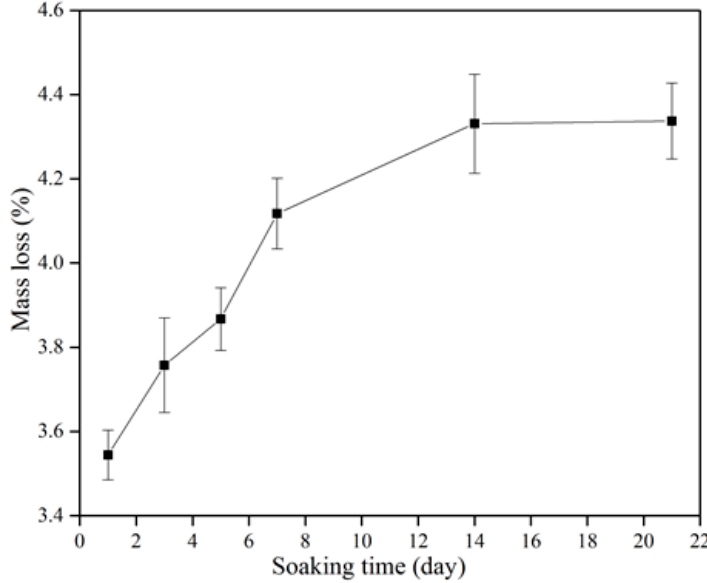
Figure 8. Degradation characteristics of the β -wollastonite sample.